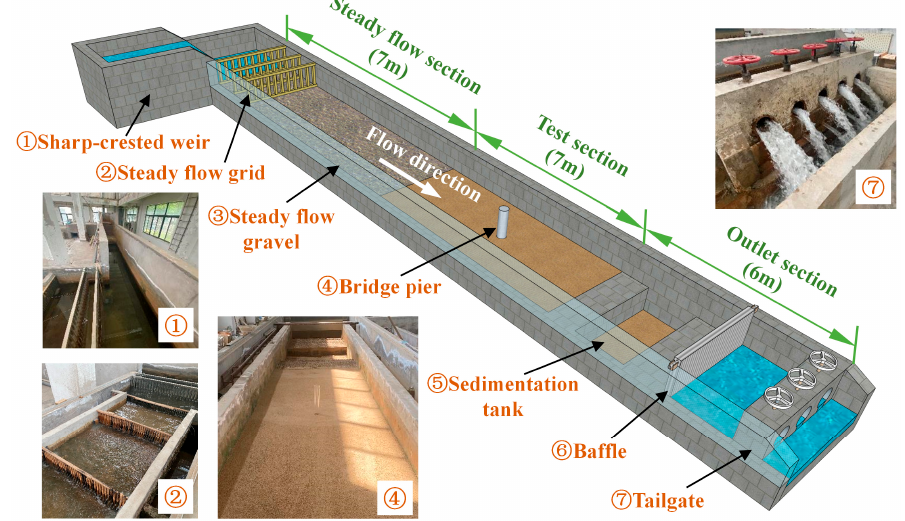
Figure 2. The test flumes.